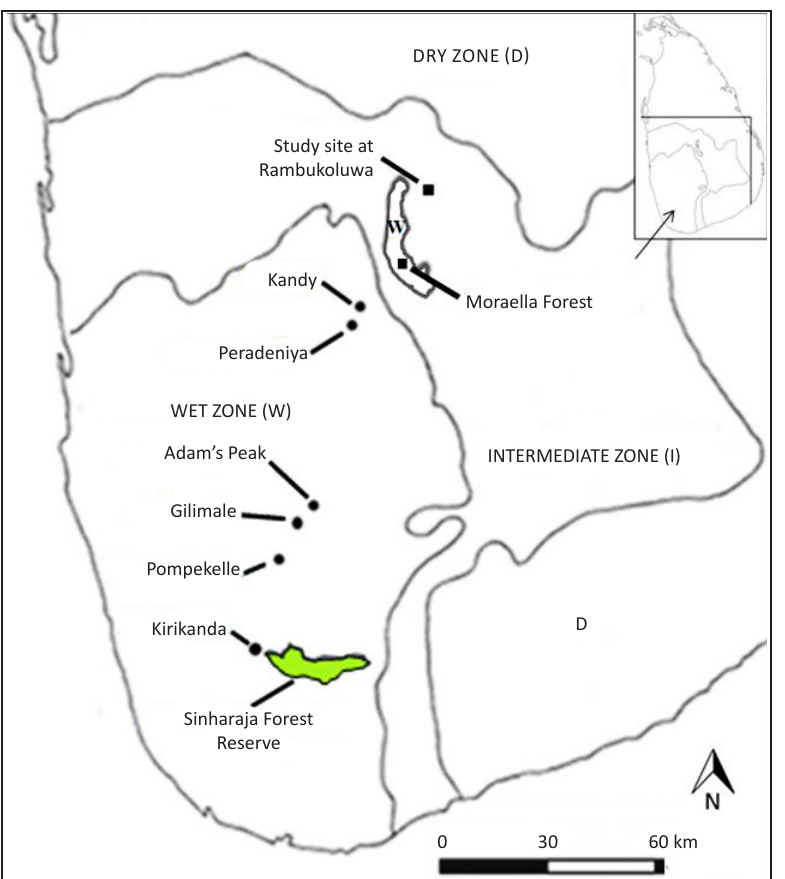
Figure 1. Map of Sri Lanka showing the localities from where Aneuretus simoni has been collected up to date (modified from Wilson et al.